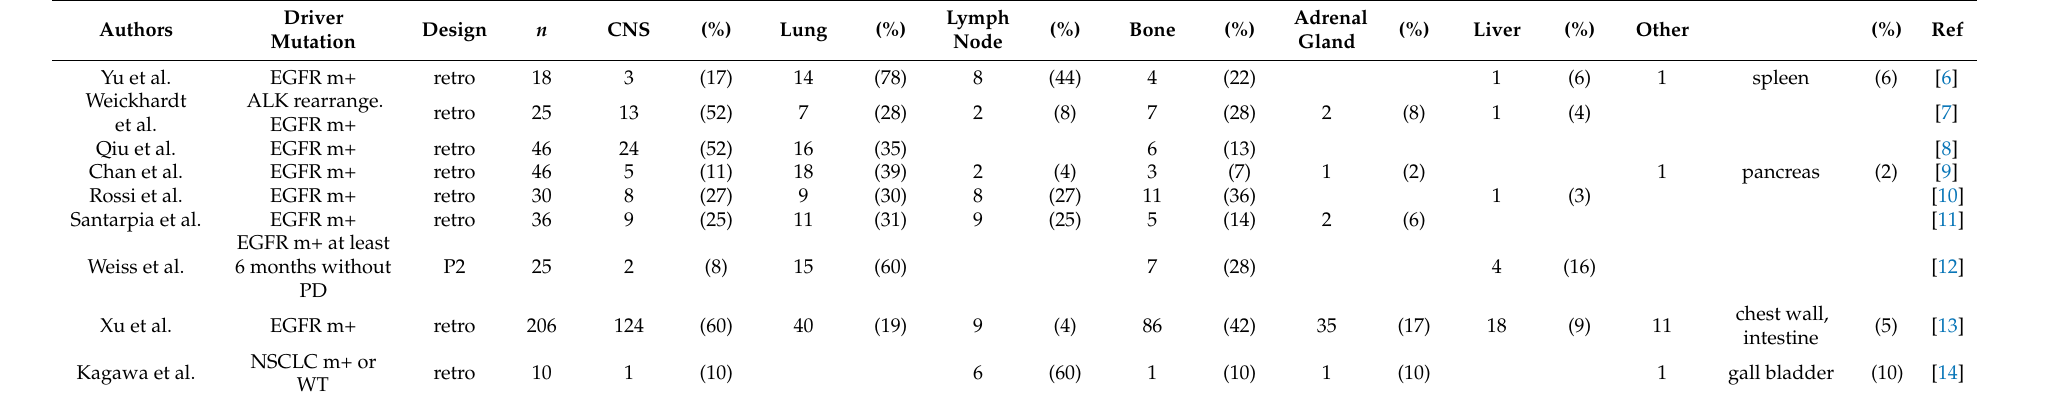
Table 1. Sites of oligoprogressive